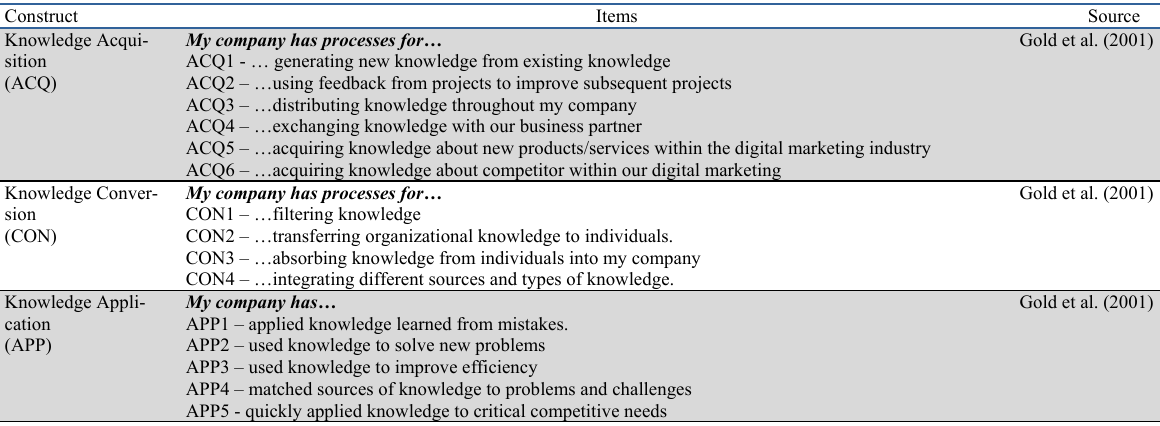
The measurement